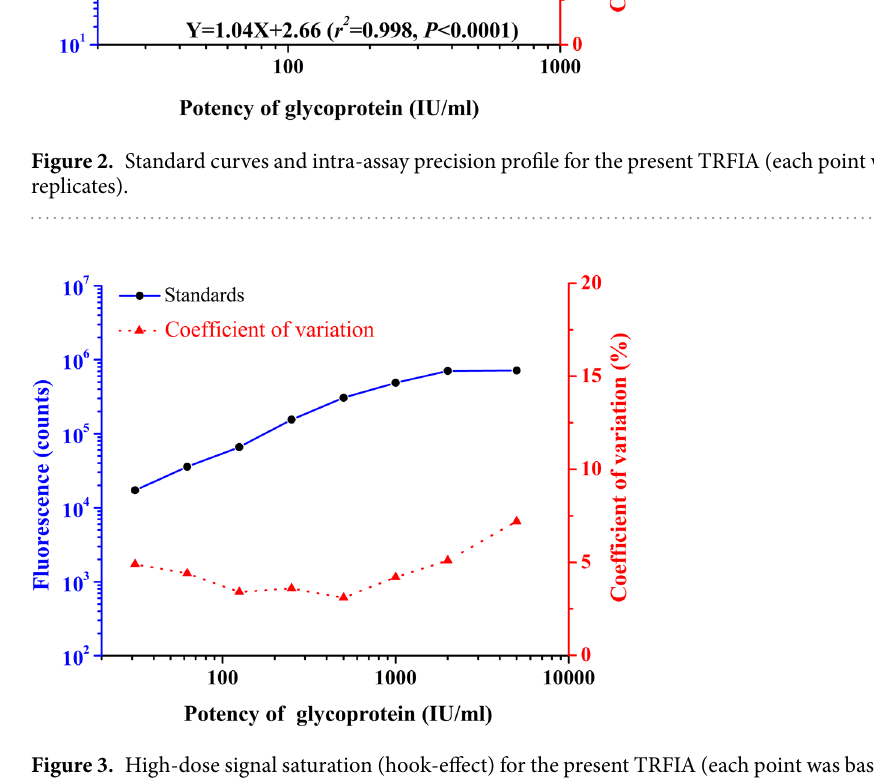
Figure 3. High-dose signal saturation (hook-effect) for the present TRFIA (each point was based on 10